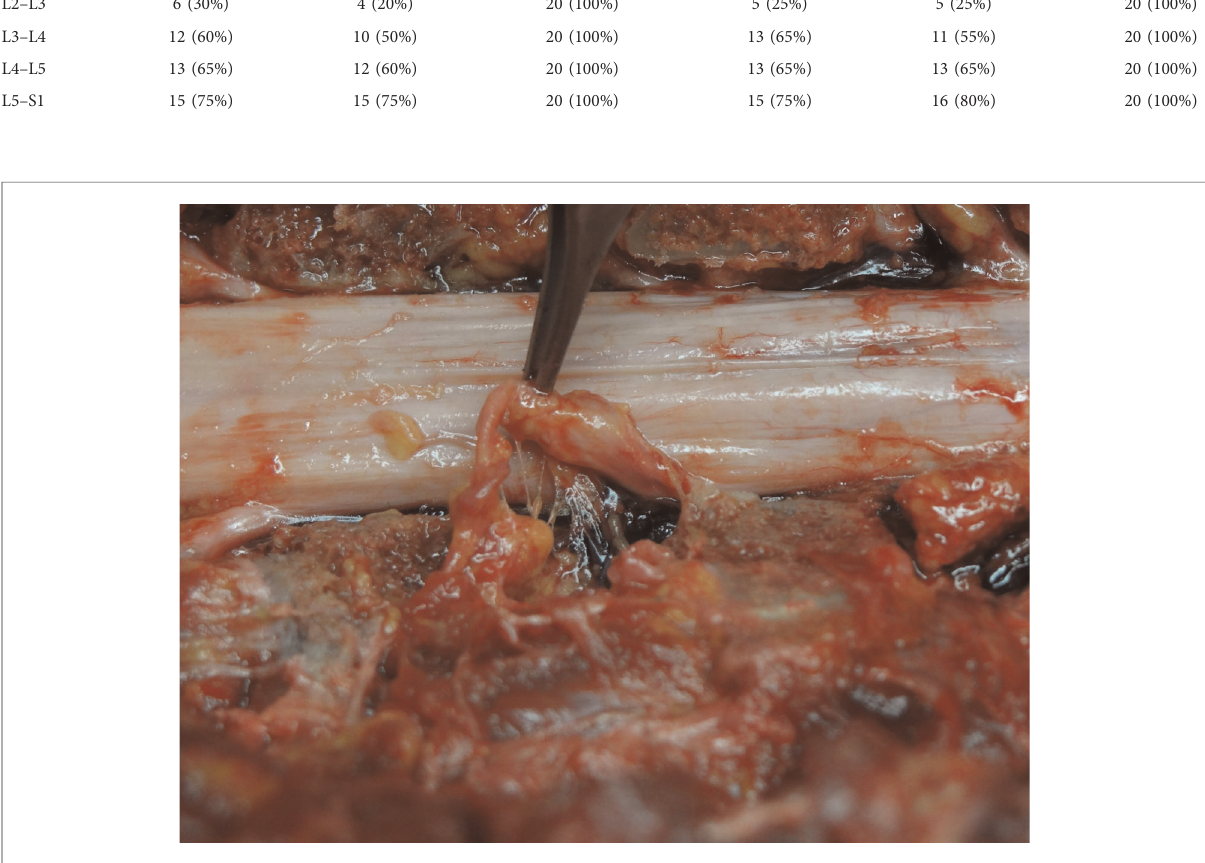
FIGURE 3 MVLs attached to the spinal nerve * — pedicles, which were removed for the visualization of the intervertebral foramen